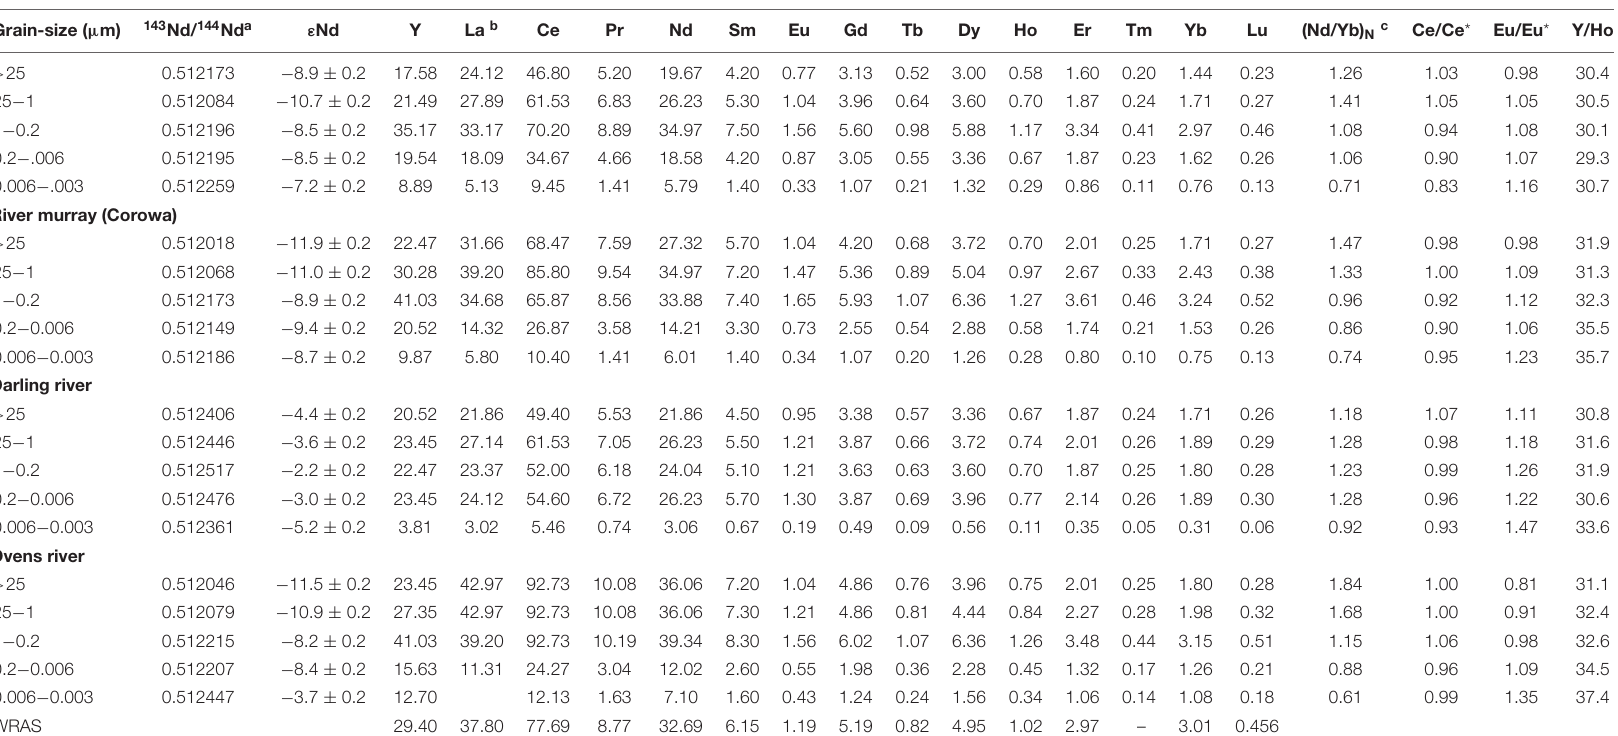
TABLE 2 | Rare earth element and Nd isotopic composition for size fractions of river suspended particulates. Grain-size ( µ m) 143 Nd/ 144 Nd